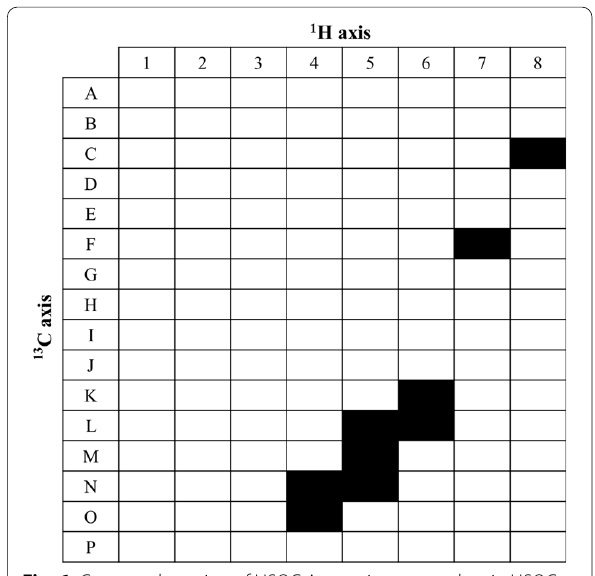
Fig. 6 Cross‑peaks region of HSQC Araucariaceae exudate in HSQC spectrum